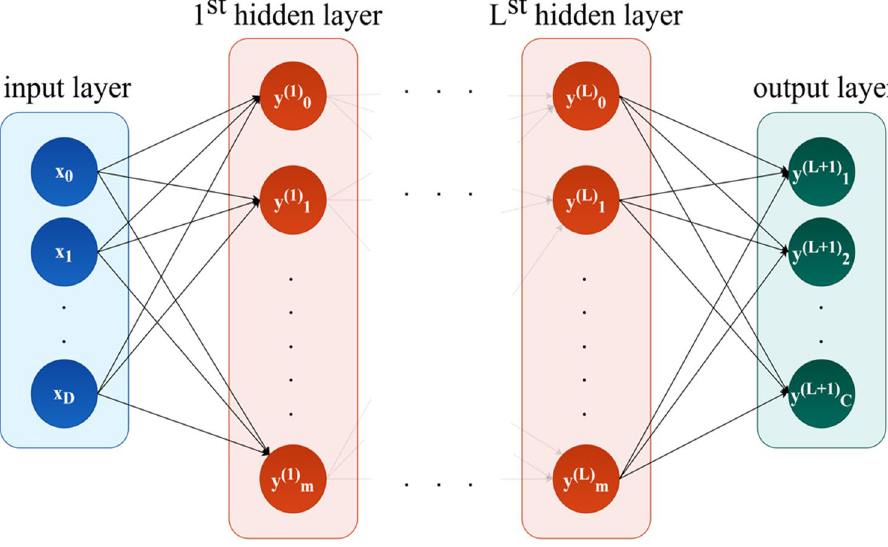
Figure 5. Feedforward fully connected neural network with (L + 1) layers with D input units and C output